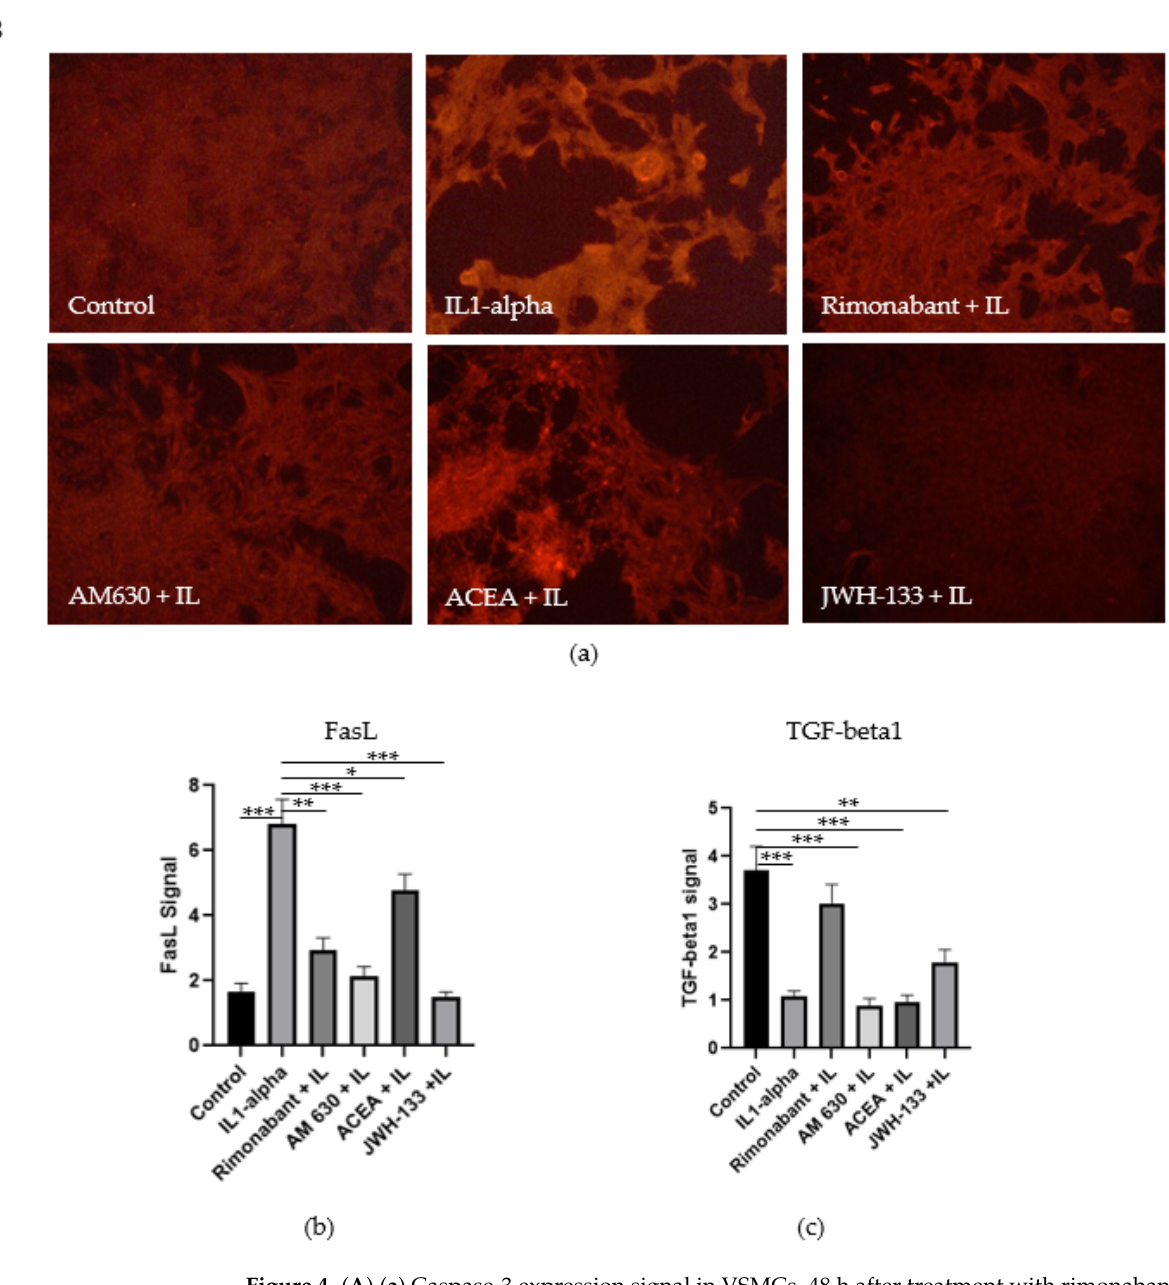
Figure 4. ( A ) ( a ) Caspase-3 expression signal in VSMCs, 48 h after treatment with rimonabant, AM 630, ACEA and JWH-133; fluorescent images obtained with Biorevo BZ 900 Microscope using 10 × magnification. Exposure time was equal in all observed groups. ( b ) Intensity of caspase-3 expression signal. The results were attained by measuring three areas of interest of the fluorescent image and subtracting the background signal ( n = 3). ( c ) Representative Western blots of caspase-3 in VSMCs, 48 h after stimulation with IL-1 α . ( B ) ( a ) FasL expression signal in VSMCs, 48 h after treatment with rimonabant, AM 630, ACEA and JWH-133; fluorescent images obtained with Biorevo BZ 900 Microscope using 10 × magnification. Exposure time was equal in all observed groups. ( b ) Intensity of FasL expression signal. The results were attained by measuring three areas of interest of the fluorescent image and subtracting the background signal ( n = 3). ( c ) Intensity of TGF-beta1 expression signal in VSMCs, 48 h after treatment with rimonabant, AM 630, ACEA, and JWH-133, attained by measuring three areas of interest of the fluorescent image and subtracting the background signal. The measurements were repeated three times per image. Statistical testing was performed using unpaired t -tests. Significance was expressed when p < 0.05; (* p < 0.05; ** p < 0.01; *** p <